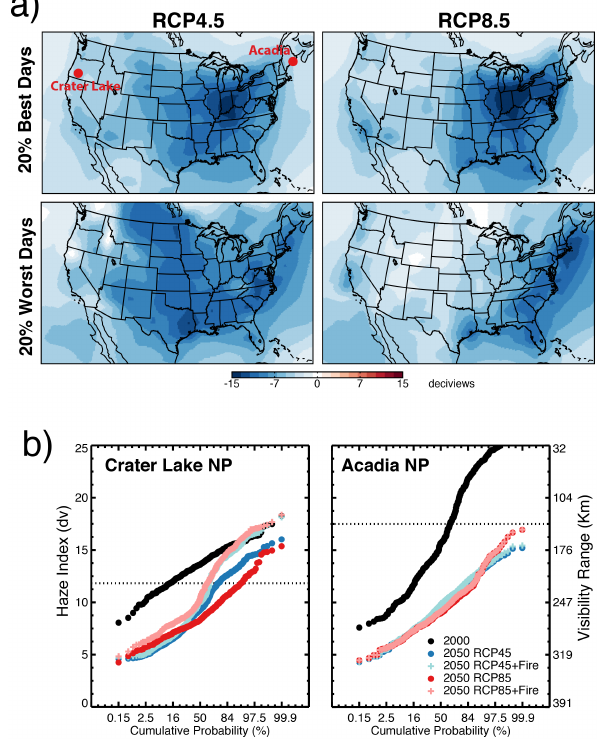
Figure 9. Projected simulated 2050–2000 changes in haze index (HI) as a result of the combination of climate, land use and emission changes (a) and the cumulative probability distributions of daily mean haze index in the Crater Lake and Acadia NPs (b) . Maps show “20% best days” as the averaged HI during the cleanest days and “20% worst days” as averaged HI during the haziest days (see text for further explanation); data are shown as interpolated contours from the 1.9 ◦ × 2.5 ◦ horizontal resolution output. The location of the Crater Lake and Acadia NPs are indicated in the top left map. The cumulative distribution plots show simulated daily HI for the present-day (black circles), 2050 projected by RCP4.5 (blue circles) and by RCP8.5 (red circles), and 2050 with the effects of climate- driven fires by RCP4.5 (light blue cross) and by RCP8.5 (light red cross). The 2050 HI target to reach natural visibility conditions by 2064 are indicated with a horizontal dotted